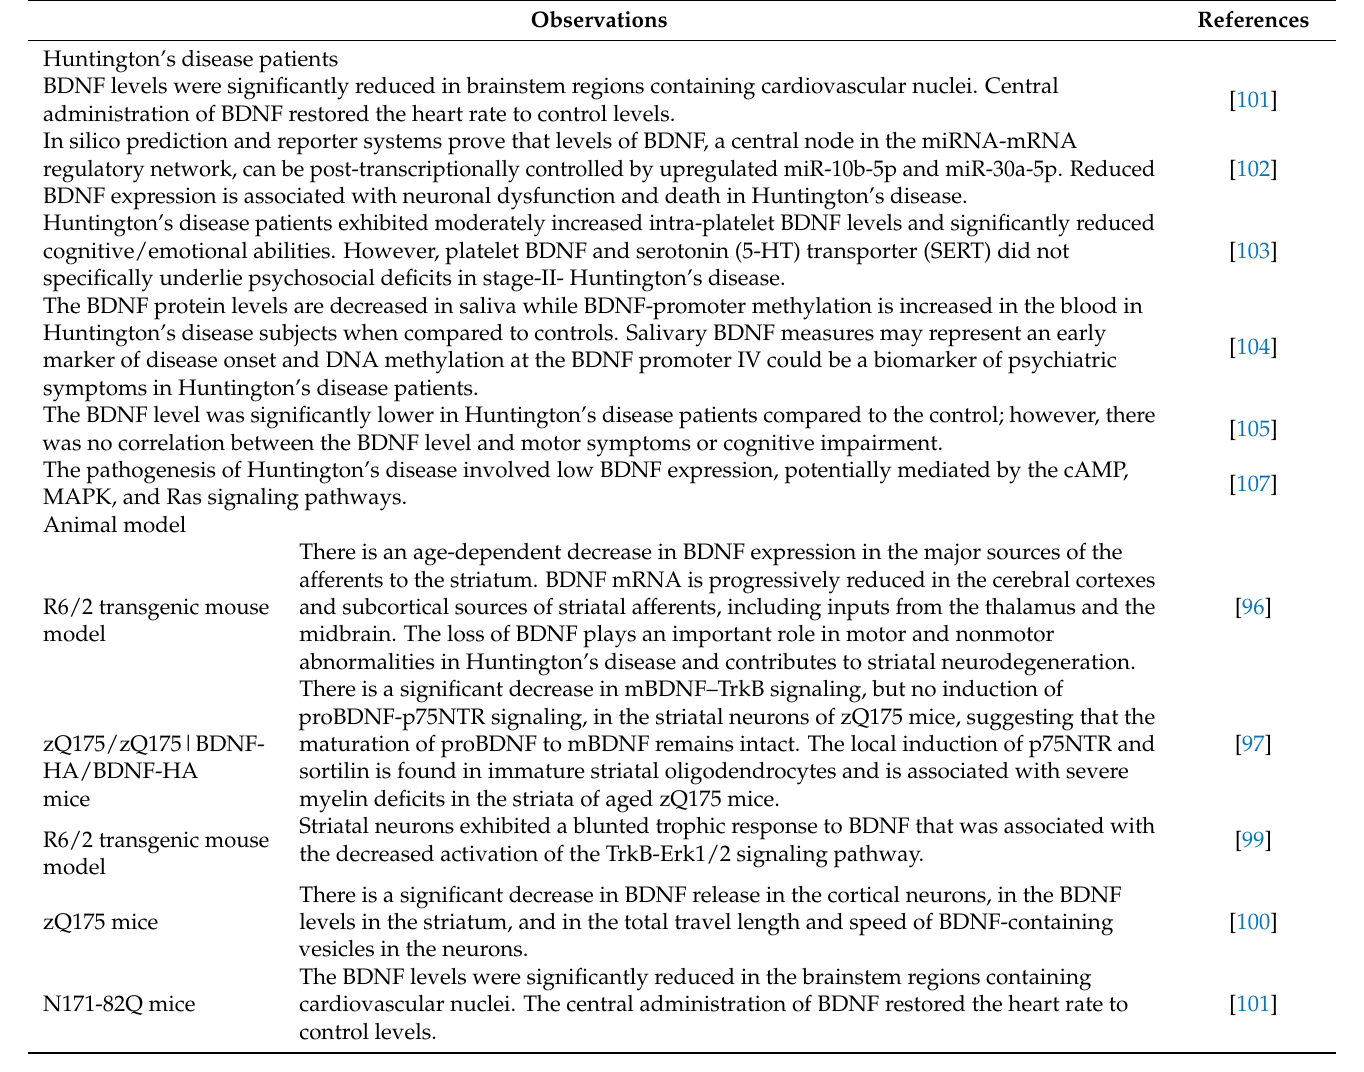
Table 3. Role of BDNF in Huntington’s